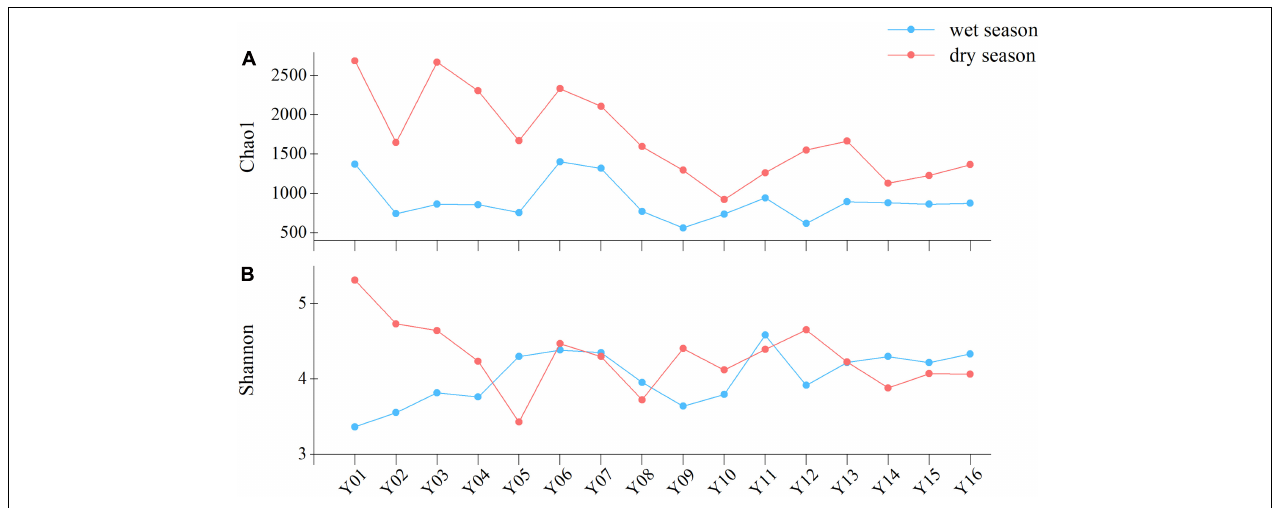
FIGURE 2 | Bacterioplankton community richness and diversity in wet and dry season communities, as measured with the (A) Chao1 richness index and (B) Shannon diversity